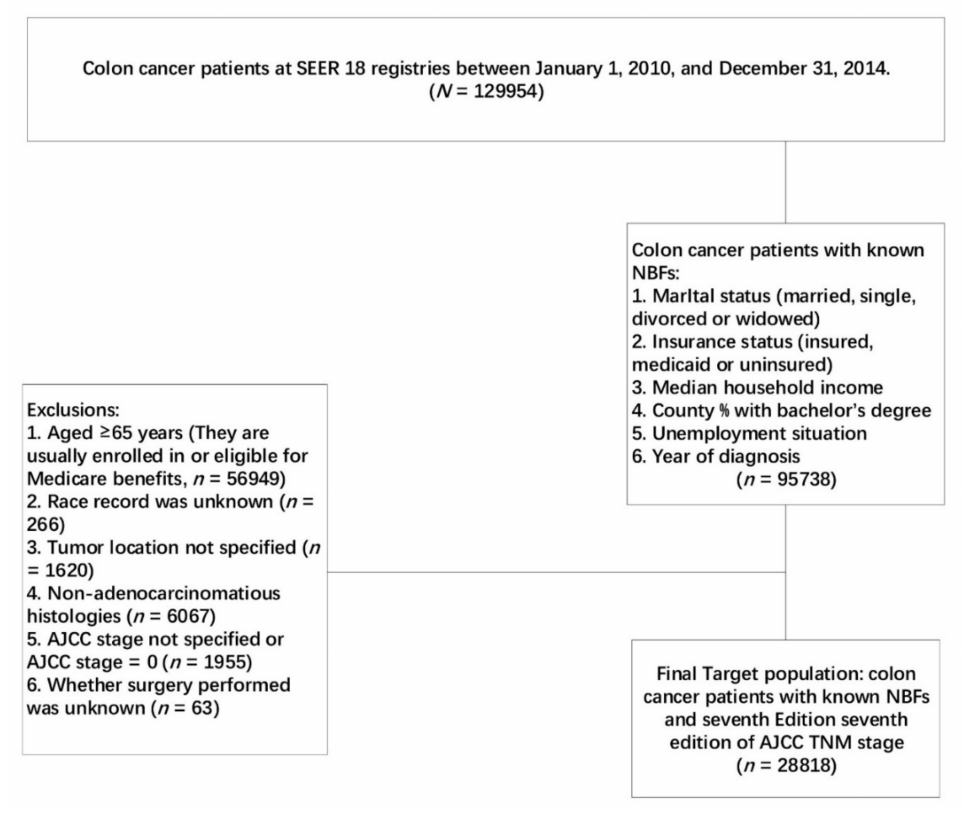
Figure 1. Flow diagram of patient population selected from Surveillance, Epidemiology, and End Results (SEER)